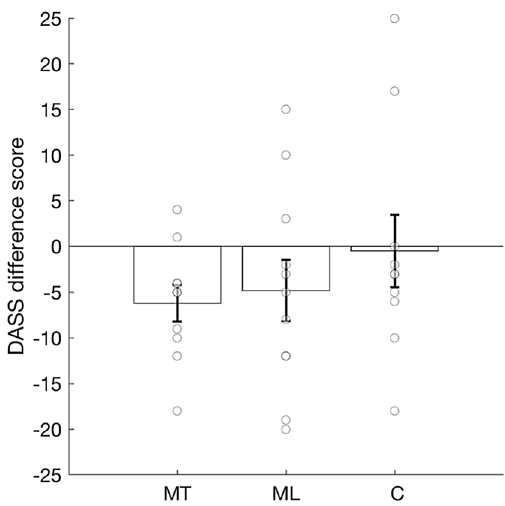
Figure 4. Decrease in negative emotional states of depression, anxiety and stress calculated as DASS difference score (DASS at the last testing session—DASS at the first testing session). Negative numbers represent a reduction in negative emotional states, while positive numbers represent an increase. Numbers around zero indicate no difference in negative emotional states by the end of the study. MT = music training group; ML = music listening group; C = control group. Error bars represent errors standard of the means and the circles represent the individual